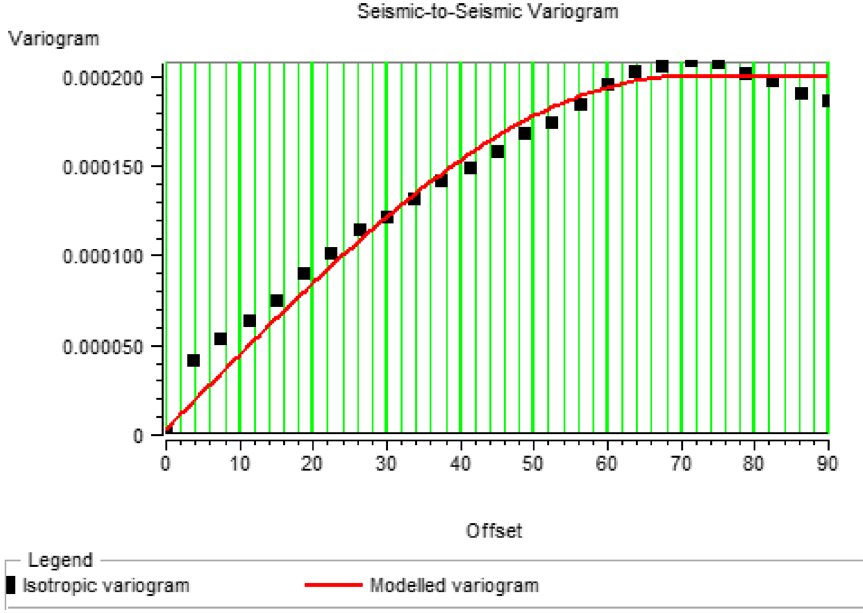
Fig. 33 The structure of